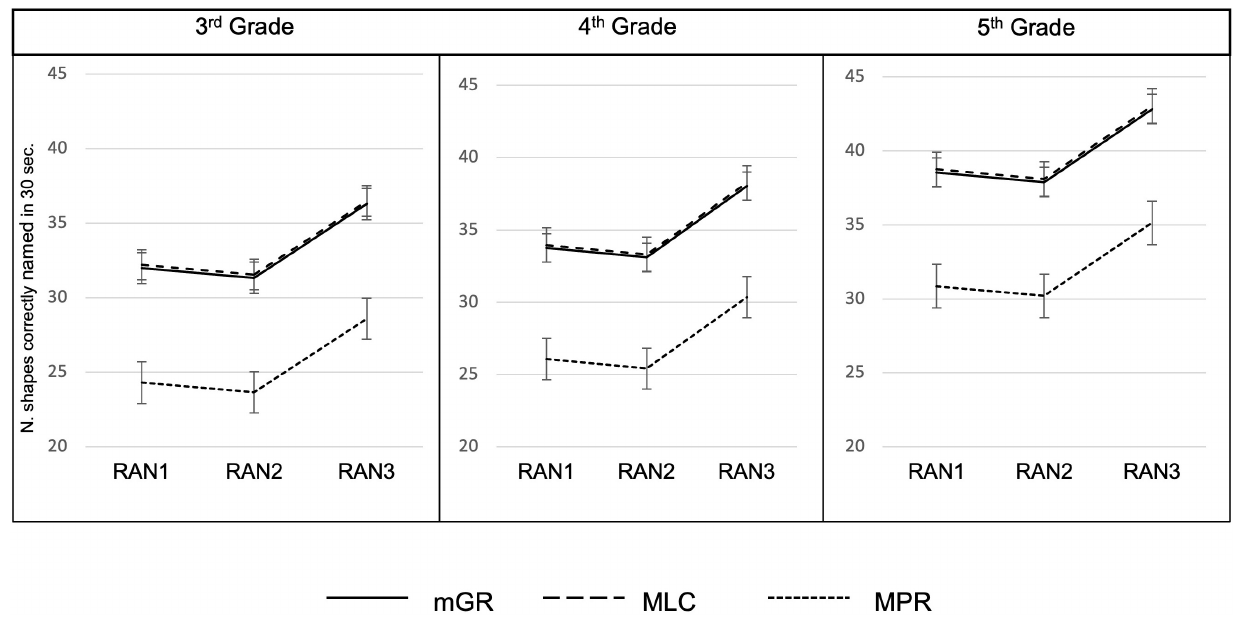
FIGURE 3 | Performances of mGR, MLC, and mPR at the three matrices of the RAN-Shapes in 3rd, 4th, and 5th